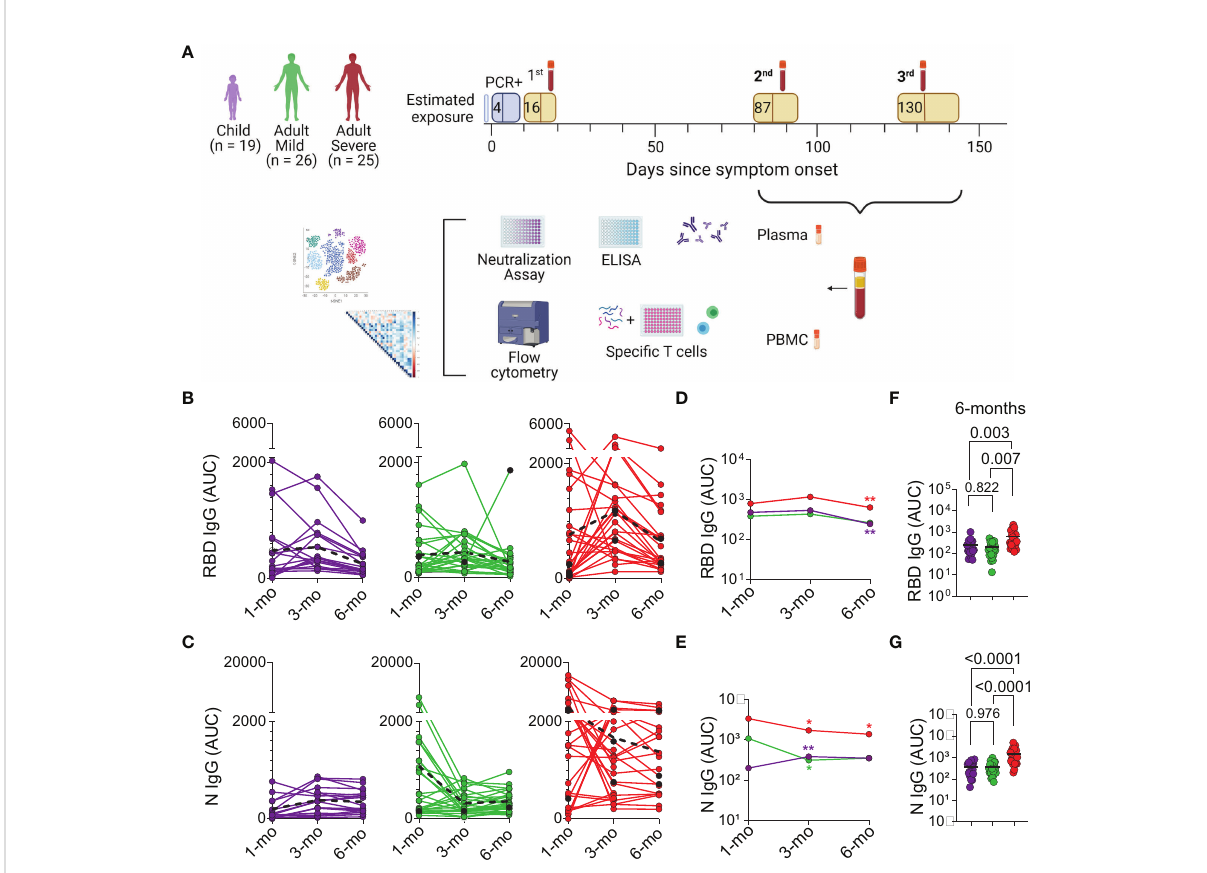
FIGURE 1 Study design and longitudinal Analysis of Antibodies. (A) Intervals of second and third blood draw from cohort patients, followed by cryopreservation and analysis. (B, C) Plasma IgG antibody binding to SARS-CoV-2 RBD and N protein, respectively, determined by enzyme- linked immunosorbent assay (ELISA), (n=70). Longitudinal analysis through connecting lines, color-coded, represented as area under the curve (AUC). Dotted lines in black highlight median values. Individuals colored in black were vaccinated between the second and the third collection point (Mild with Astrazeneca and Severe with Sinovac). (D, E) Median titers plotted over time. Differences among group pro fi les were analyzed using Generalized Estimating Equations (GEE) and sequential Sida ́ k ’ s adjustment for pairwise multiple comparisons, colored asterisk (*) indicate statistical difference compared to previous point of collection. (F, G) Individual AUC 6 months after acute infection, in the three groups of patients; The horizontal bar is the median, P values are displayed over brackets. Graphical study design was created with